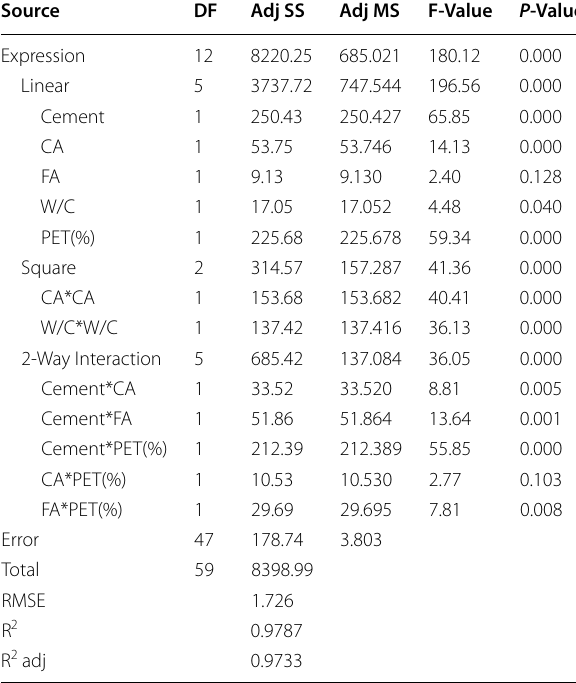
Table 4 RSM of PET-FA